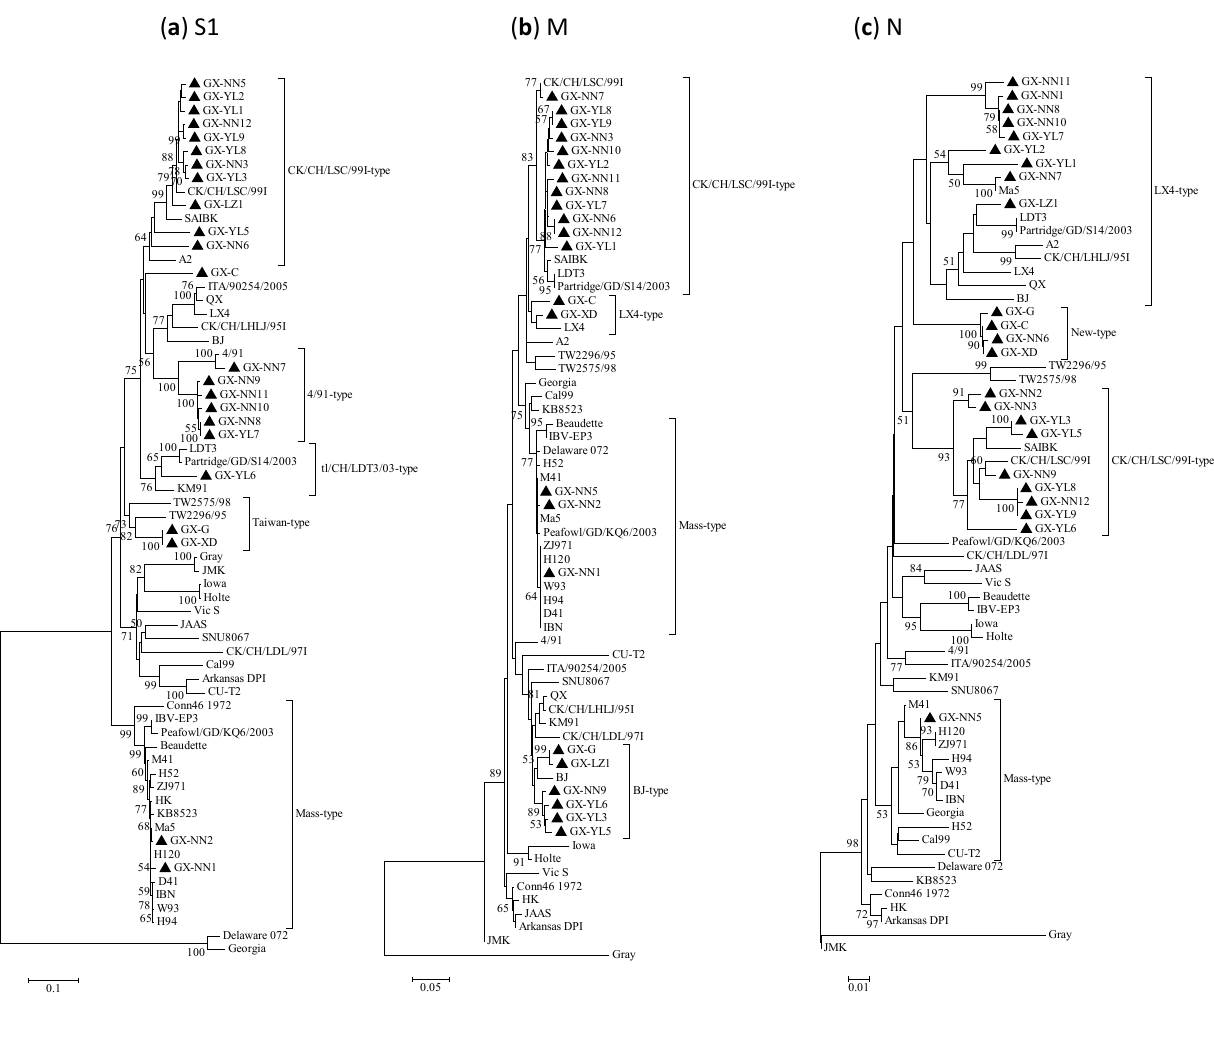
Figure 1. Phylogenetic trees of gene ( a ) S1, ( b ) M and ( c ) N of infectious bronchitis viruses (IBVs), where the 23 IBV strains are marked with filled triangle. Phylogenetic trees were constructed with the neighbor-joining method using MEGA 5.05 version. The bootstrap values were determined from 1000 replicates of the original data. The branch number represents the percentage of times that the branch appeared in the tree. Bootstrap values greater than 70% are shown. The p-distance is indicated by the bar at the bottom of the